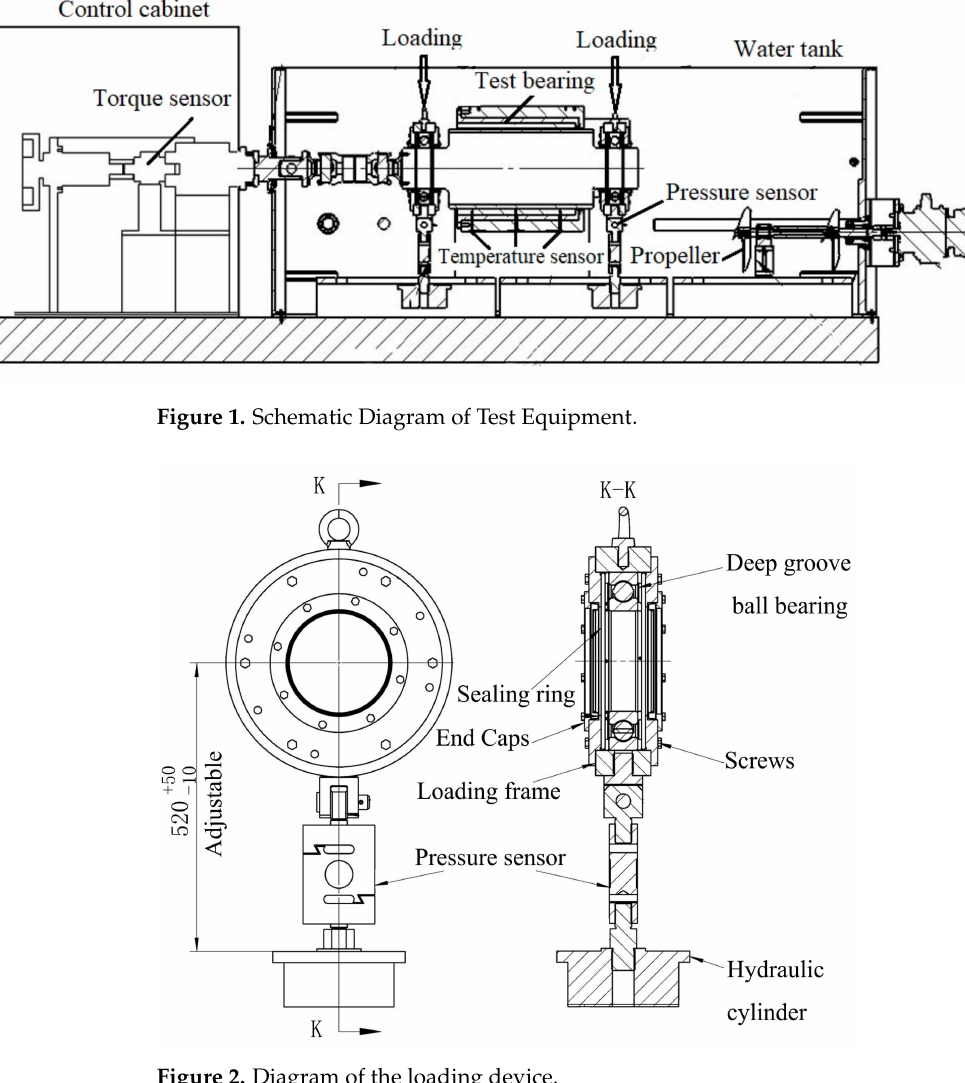
Figure 2. Diagram of the loading device. Table 1. Properties of polymer bearing